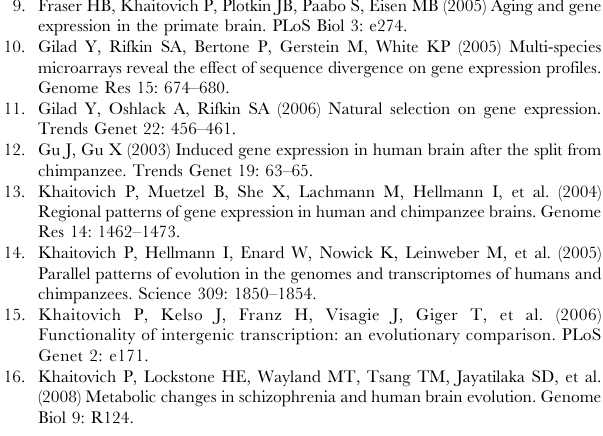
Table S1 Complete results from the candidate control genes selection